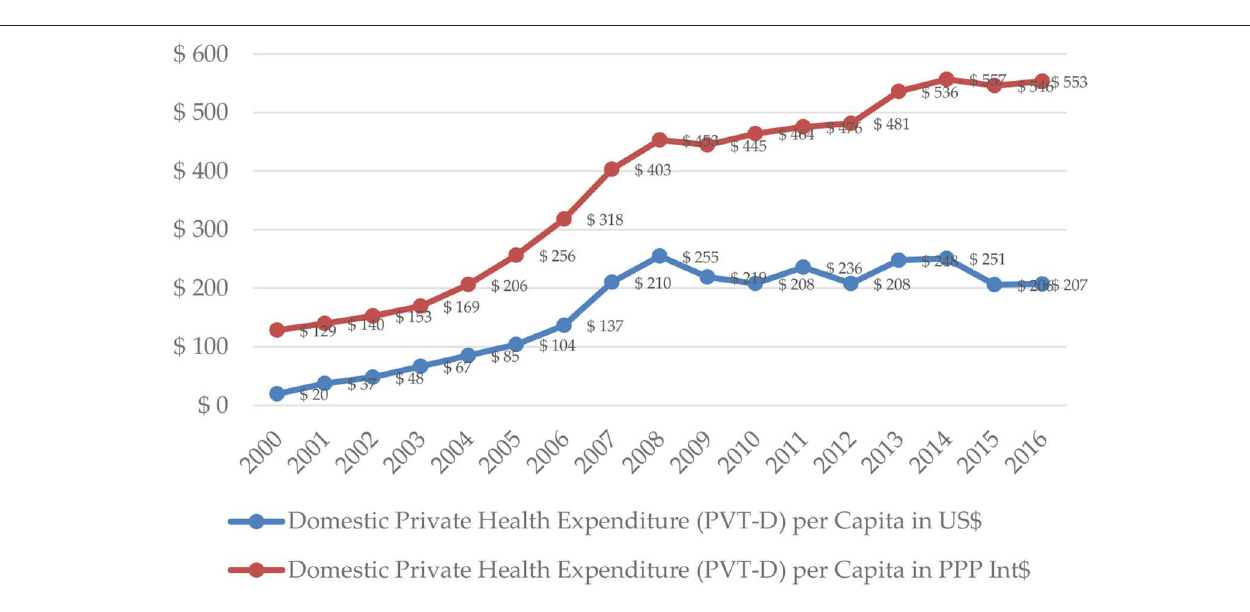
FIGURE 4 | Domestic private expenditure per capita in Serbia in 2000–2016. Source: WHO Global Health Expenditure